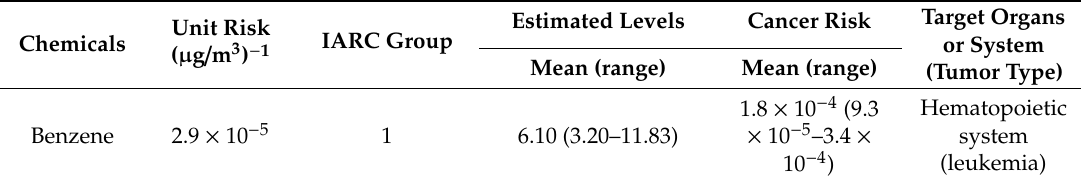
Table 5. Estimated levels ( µ g / m 3 ) and potential cancer risk for residents exposed to benzene in the vicinity of an optoelectronics industrial